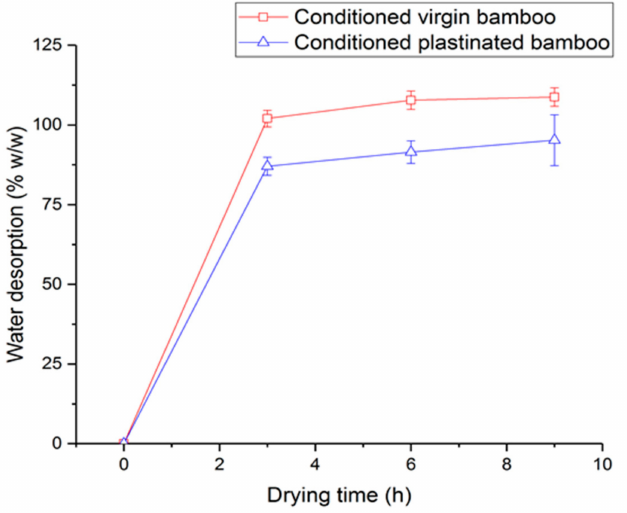
Figure 6. Weight fraction of water desorbed by conditioned virgin and conditioned plastinated bamboo vs. drying time in the oven, showing lower moisture absorbed by plastinated